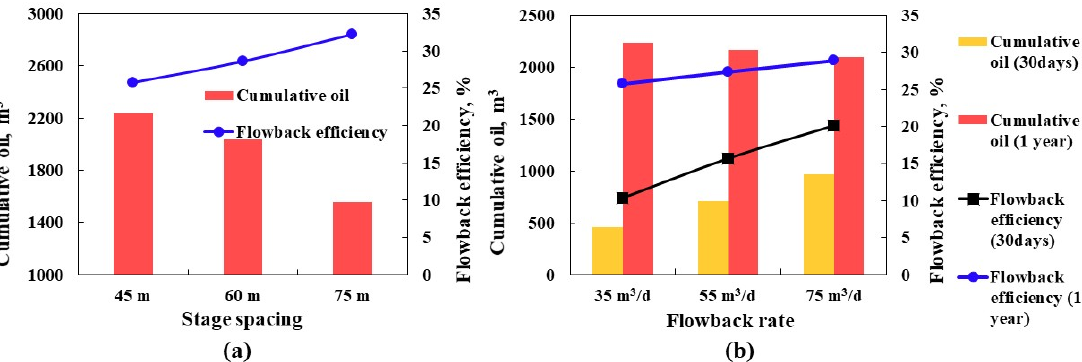
Figure 9. Cumulative oil and flowback efficiency profiles: ( a ) stage spacing. ( b ) flowback rate.